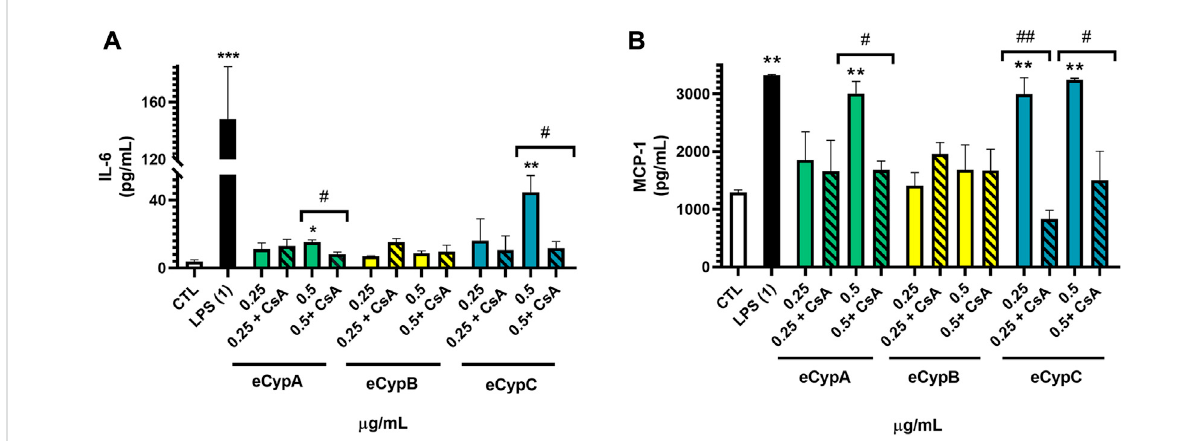
Effect of eCyps on in fl ammatory mediators release. (A) Levels of IL-6 in cell supernatant. (B) MCP-1 release of MS1 cells after eCyps addition. Endothelial cells were treated with eCyps A, B and C at 0.25 and 0.5 μ g/ml for 24 h and levels of pro-in fl ammatory markers were assessed with a commercial multiplex kit. LPS at 1 μ g/ml was used as pro-in fl ammatory control and pre-treatment with 0.2 μ M CsA was performed to counteract eCyps effects. Results are mean ± SEM of three independent replicates. Statistical signi fi cance determined with one way ANOVA followed